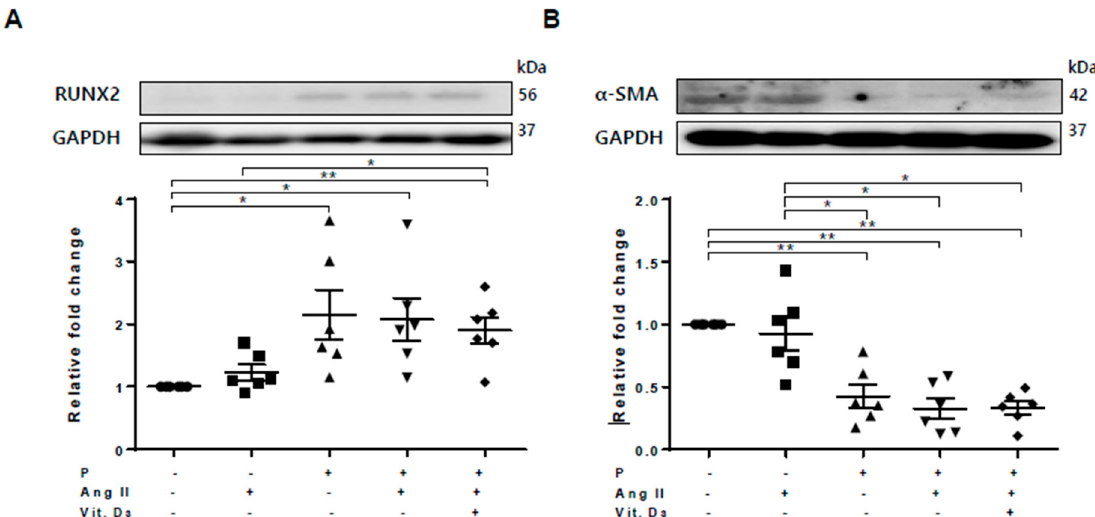
Figure 1. Osteoblastic trans-differentiation of vascular smooth muscle cells (VSMCs) is induced in a chronic kidney disease (CKD) environment. VSMCs were treated with angiotensin II and vitamin D in high-phosphate medium to mimic CKD conditions. Six replicates per condition were performed. The protein levels of Runt-related transcription factor 2 (RUNX2) and α –smooth muscle actin ( α -SMA) levels were determined using Western blotting and normalized to glyceraldehyde 3-phosphate dehydrogenase (GAPDH). Bar charts represent the densitometric quantification of immunoblots. ( A ) The expression of RUNX2 was significantly increased in vascular calcification (VC) medium compared with the control; ( B ) The expression of α -SMA was reduced in VC induction medium compared with the control. Data are expressed as means ± standard errors of the mean from six independent experiments. * p < 0.05, ** p < 0.01.